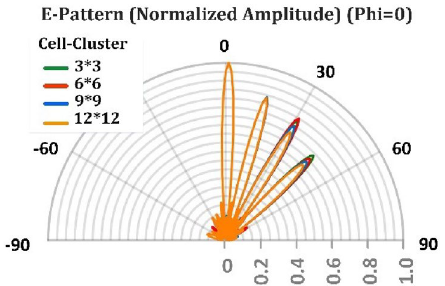
Figure 14. Variation of beam direction in four angels of 0 ◦ , 15 ◦ , 30 ◦ , 45 ◦ , for different cell-cluster dimension.